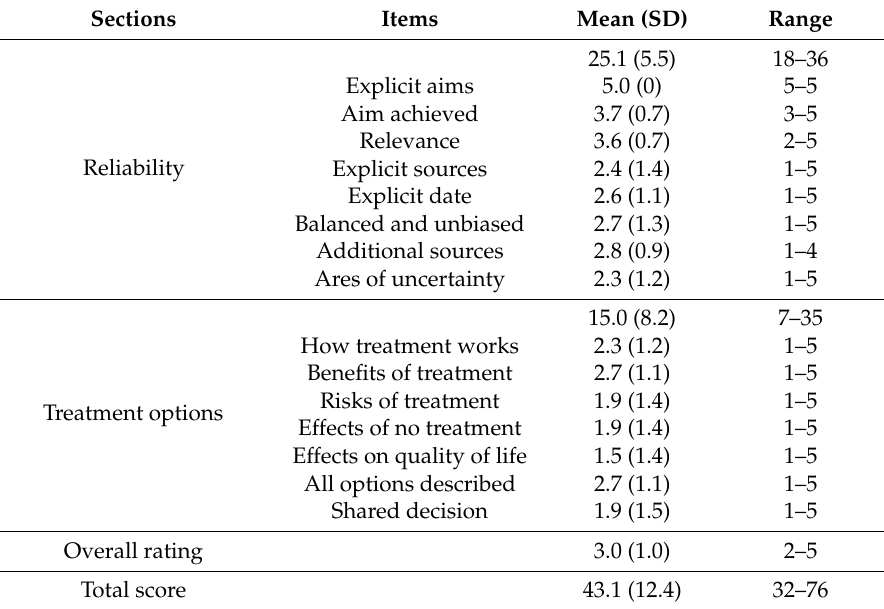
Table 4. Scores of the top 15 websites measured by the DISCERN